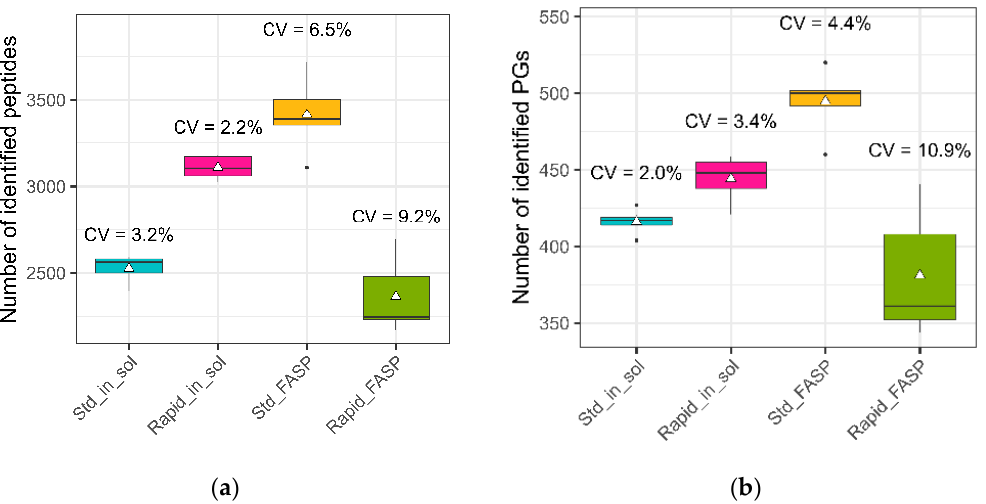
Figure 5. Number of identifications for the CSF samples obtained with the MaCProQC tool. The number of identified peptides ( a ) and protein groups ( b ) as well as the variation of these values between replicates were analyzed for all four sample preparation strategies. Rapid FASP showed the lowest average identification number for both peptides and protein groups, while standard FASP showed the highest, but with a higher variation compared to the in-solution digestion proto- cols.